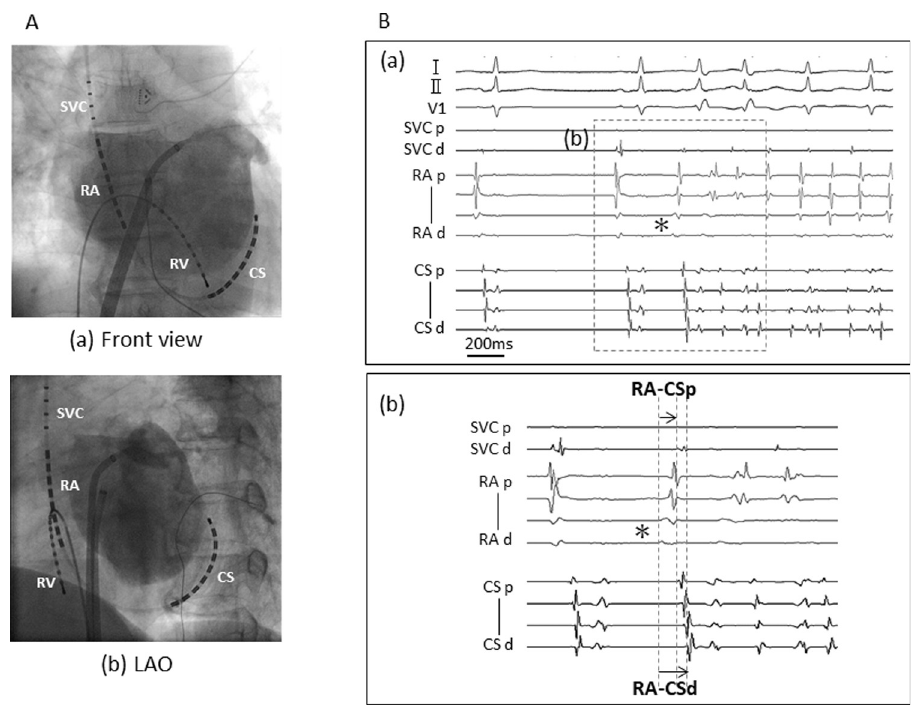
Fig 1. Catheter position and intra-cardiac electrograms of AF initiation by a non-PV trigger. A, basically- positioned RA-CS catheter and RV catheter in front view (a) and LAO (b). B, Surface electrocardiograms and intra- cardiac electrograms of AF initiation by a non-PV trigger (a) and focused intra-cardiac electrograms of the premature atrial beat of a non-PV trigger indicating intra-cardiac activation intervals analyzed in the present study (b). RA-CSp and RA-CSd are the intra-atrial activation interval from the earliest in RA to proximal CS and that from the earliest in RA to distal CS, respectively. RA, right atrium; CS, coronary sinus; RV, right ventricle; LAO, left anterior oblique; SVC, superior vena